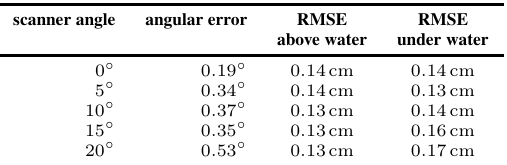
Table 2. Angular errors between the plane normals above and below water for the corrected reconstruction result. Root mean square error (RMSE) of the plane